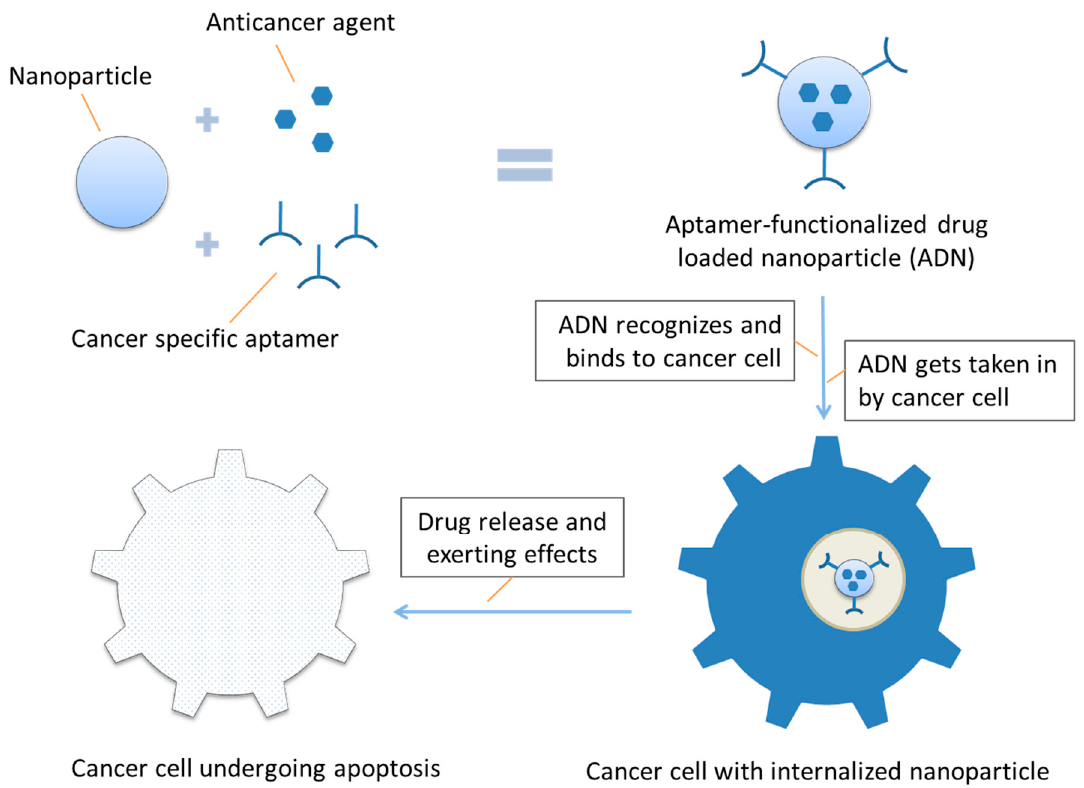
Figure 3. Schematic representation of aptamer-functionalized nanoparticle acting on a cancer cell.